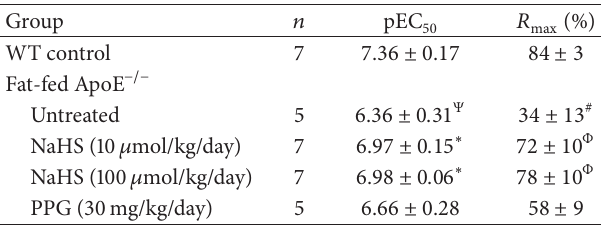
# ,Ψ 𝑃 < 0.05 , 𝑡 -test, WT versus fat-fed ApoE −/− , ∗,Φ 𝑃 < 0.05 , ANOVA, untreated versus treated.